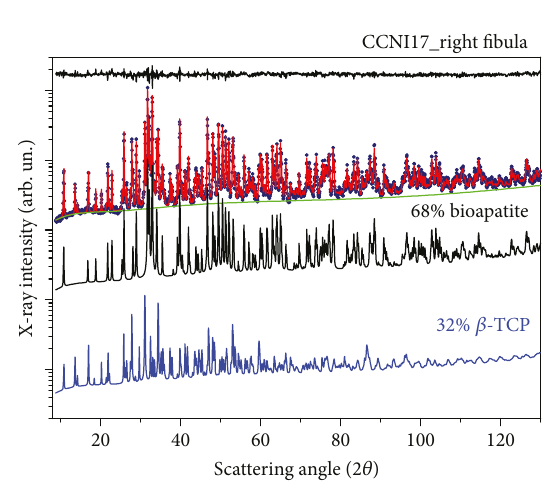
Figure 2: CC/NI/17_right fi bula represents one of the rare bone specimens showing a partial transformation to β -TCP. According to Rietveld analysis, the amount of bioapatite is 68 wt% and 32 wt% belongs to β -tricalcium phosphate. The residuals are reported on the top of the graph for ease of